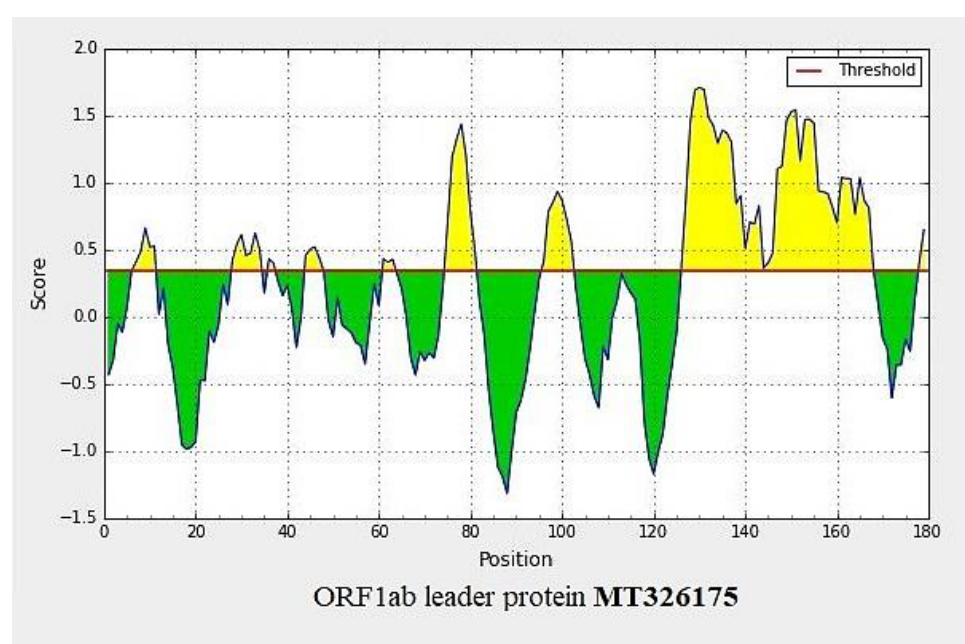
Figure 2. B-cell epitope prediction of the ORF1ab leader protein